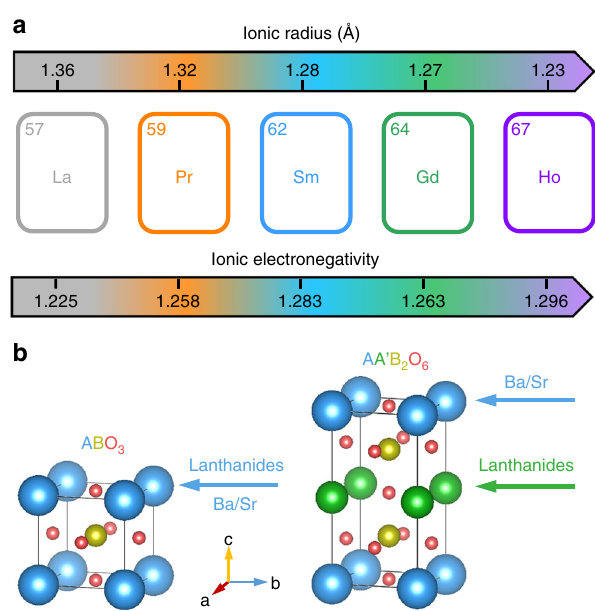
Fig. 1 Design of A-sites in perovskite lattice. a Values of ionic radius and ionic electronegativity for La 3 + , Pr 3 + , Sm 3 + , Gd 3 + , and Ho 3 + cations with 12-fold coordination, which exhibit the lanthanide contraction and gadolinium break phenomena, respectively. b Doping lanthanides and alkaline-earth metal cations into cobalt-based single perovskites ABO 3 (B = Co) and A-site ordered double perovskites AA ′ B 2 O